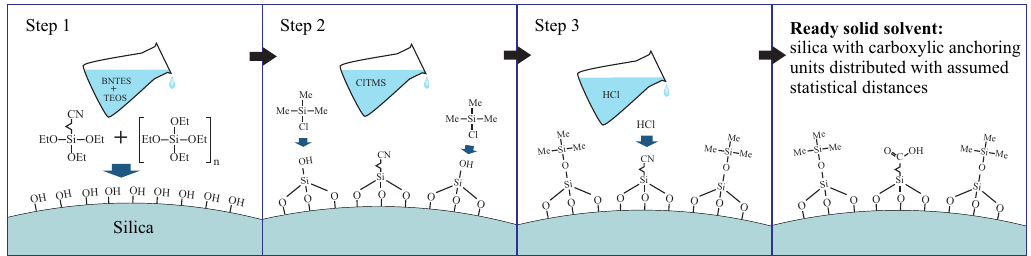
Figure 18. A schematic illustration of the synthesis of spherical silica containing carboxylic anchoring units distributed with the assumed statistical distances. Abbreviations: TEOS—tetraethyl orthosilicate, BNTES—butyronitriletriethoxysilane, ClTMS—chlorotrimethylsilane, Me—methyl groups, Et—ethyl units. The number n deneotes the density of anchoring units.